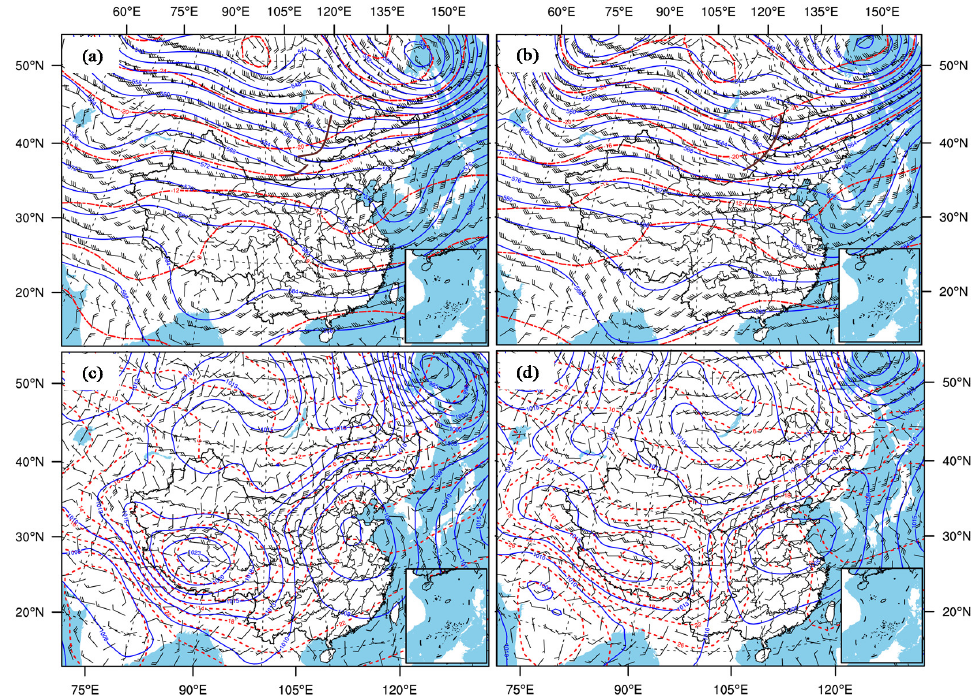
Figure 4. NCEP reanalyzed synoptic situation at 500hPa (top panel, ( a ), ( b )) and surface (bottom panel, ( c ), ( d )) at 20:00 on 2 May (left panel, ( a ), ( c )) and at 08:00 on 3 May (right panel, ( b ), ( d )). The red dashed lines represent the isotherms (°C). The blue solid lines represent the height contours (dagpm) in ( a ) and ( b ) and surface pressure (hPa) in ( c ) and ( d ).